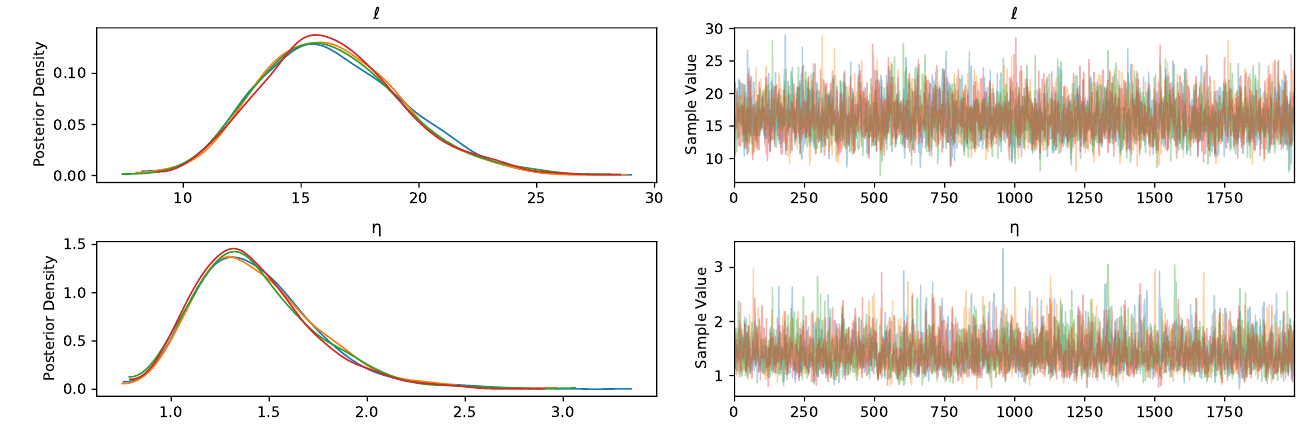
Figure 5. Posterior distributions ( left column ) and trace plots ( right column ) for the Blue Buttes Field detection count model. Well mixing and convergence of the Markov chains are achieved.